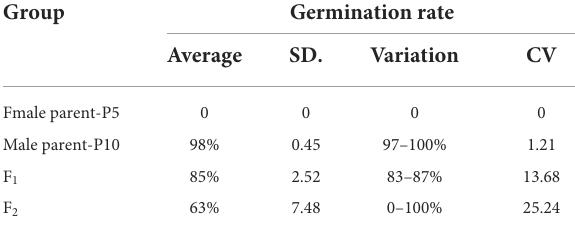
TABLE 3 The germination rate in 48h after germination for melon seeds under the treatment of 28 ◦ C with 8h soaking. Group Germination rate Average